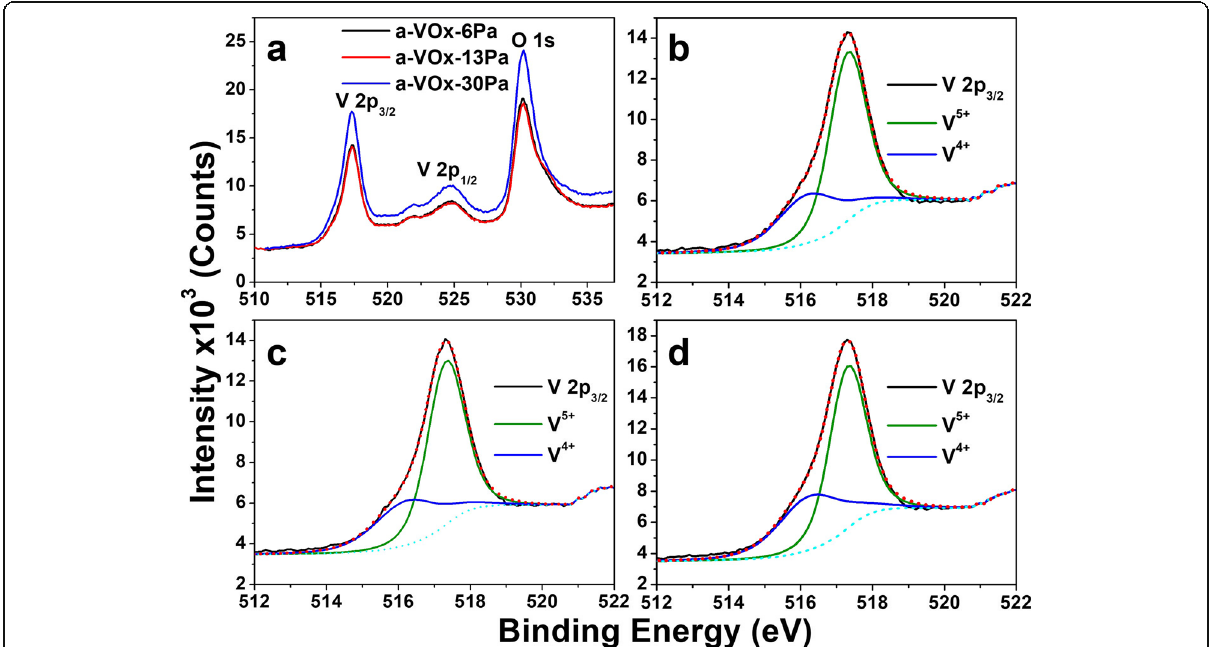
Fig. 3 High-resolution XPS spectra of a-VOx films ( a) O 1s and V 2p core level; V 2p 3/2 of ( b ) a-VOx-6 Pa, ( c ) a-VOx-13 Pa and ( d ) a-VOx-30